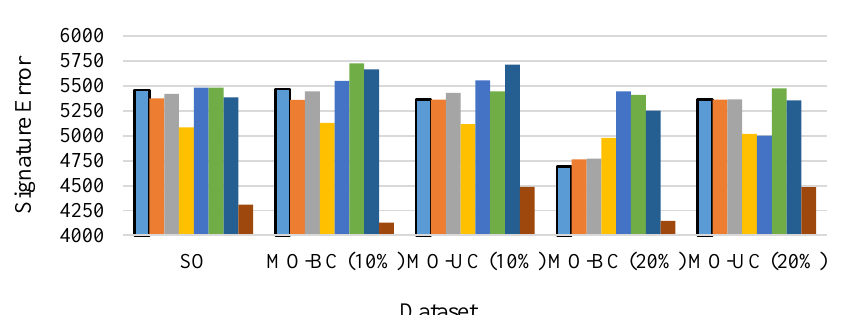
Figure 18. FLV (FDC) errors based on observations and simulations of five datasets using two main calibration approaches (SO & 4 algorithms parameterization of MO-SB).